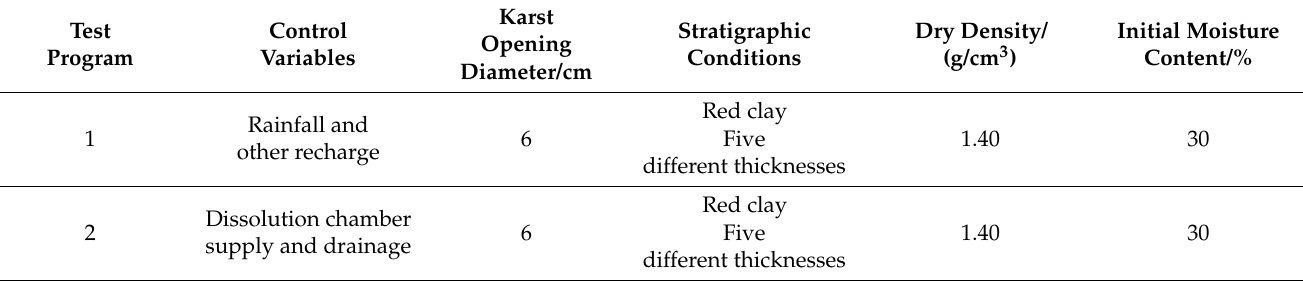
Table 2. Physical simulation test program for karst